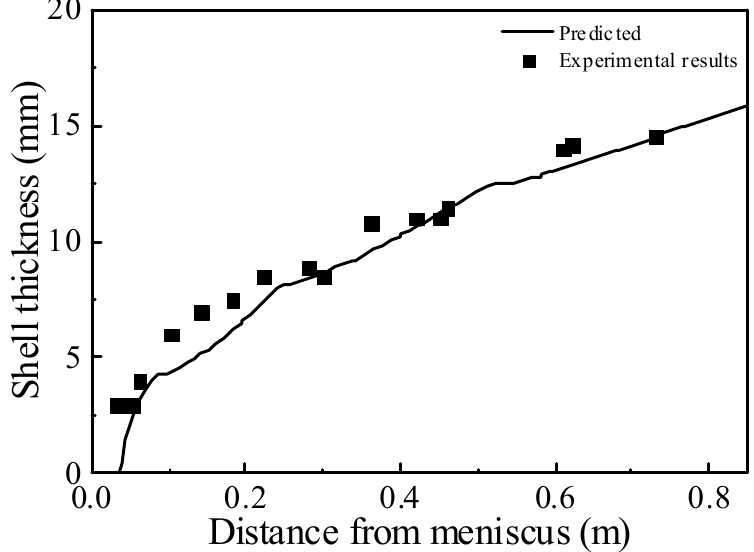
Figure 5. Validation of solidification model.